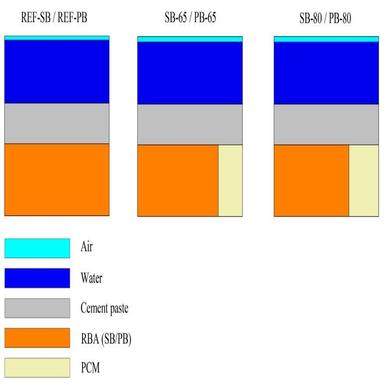
Schematic representation of the volumetric compositions of the reference mortar (REF-SB/REF-PB) and the two mixtures having a PCM filling degree of 65 Vol.% (SB-65/PB-65) and 80 Vol.% (SB-80/PB-80) in the RBA open porosity.